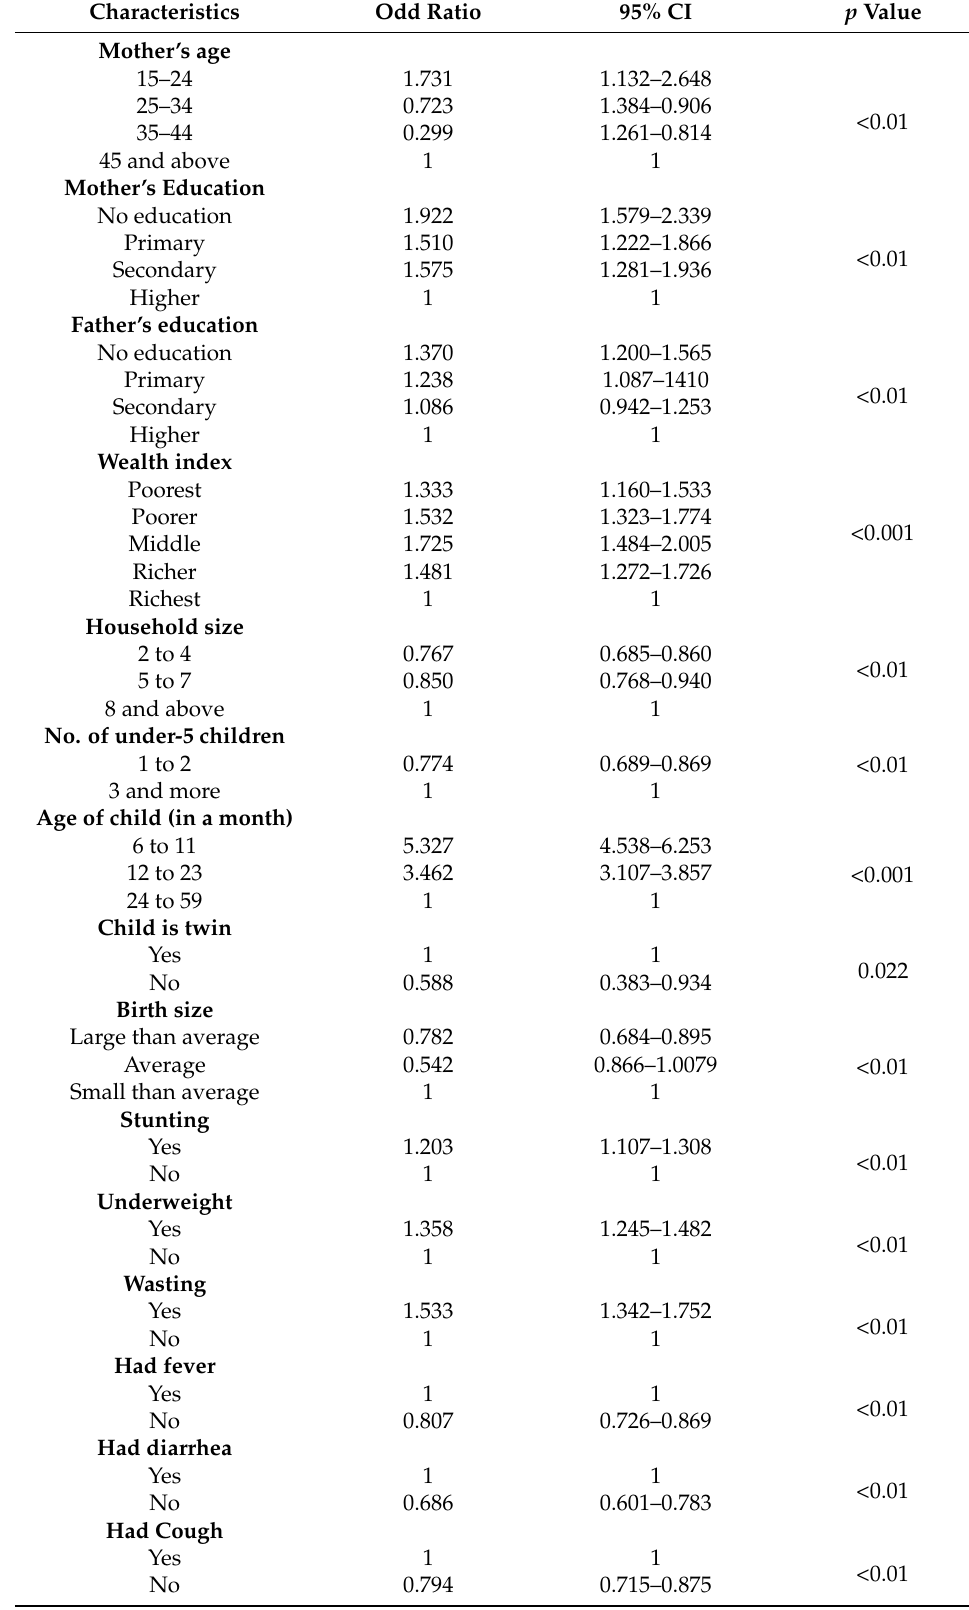
Table 4. Unadjusted association between predictor variables and